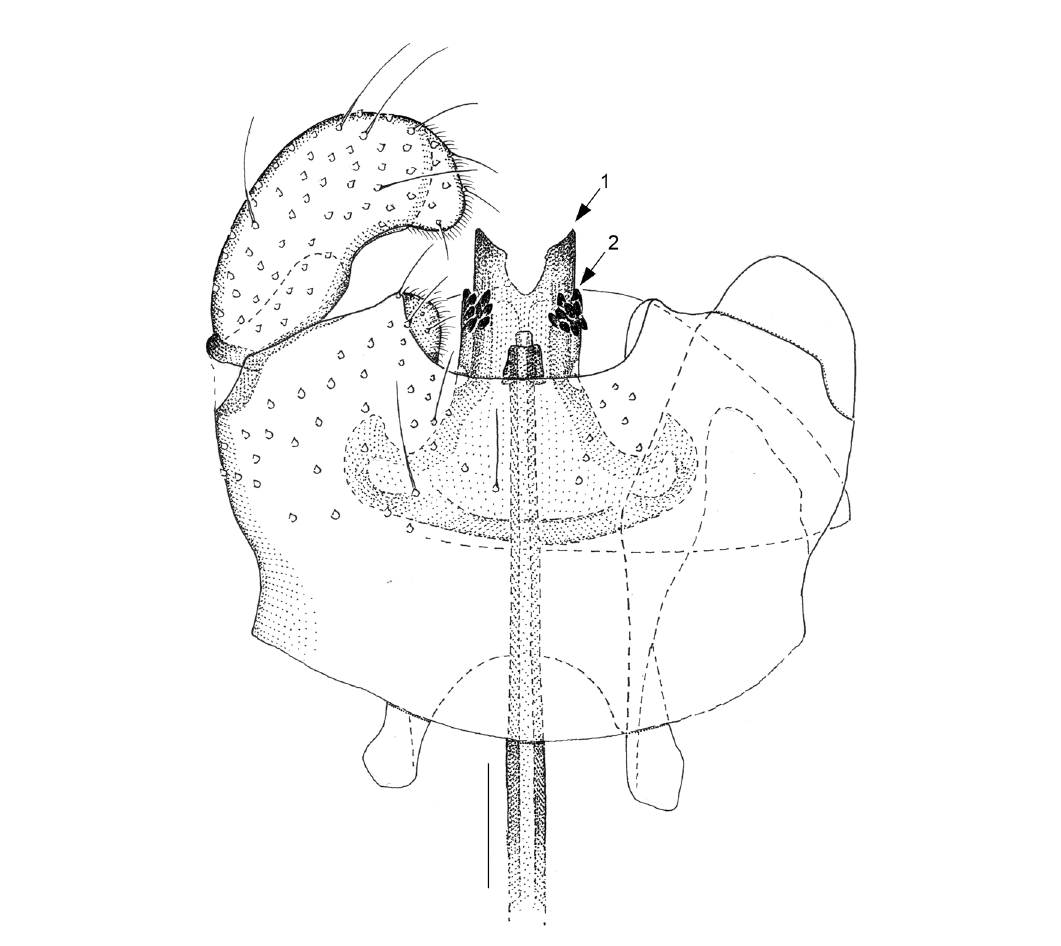
Fig. 11. Genitalia of Glemparon otago sp. nov., holotype, ♂ (NZAC, no. CEC1410). Scale bar = 0.05 mm. Numbered arrows indicate diagnostic characters (see